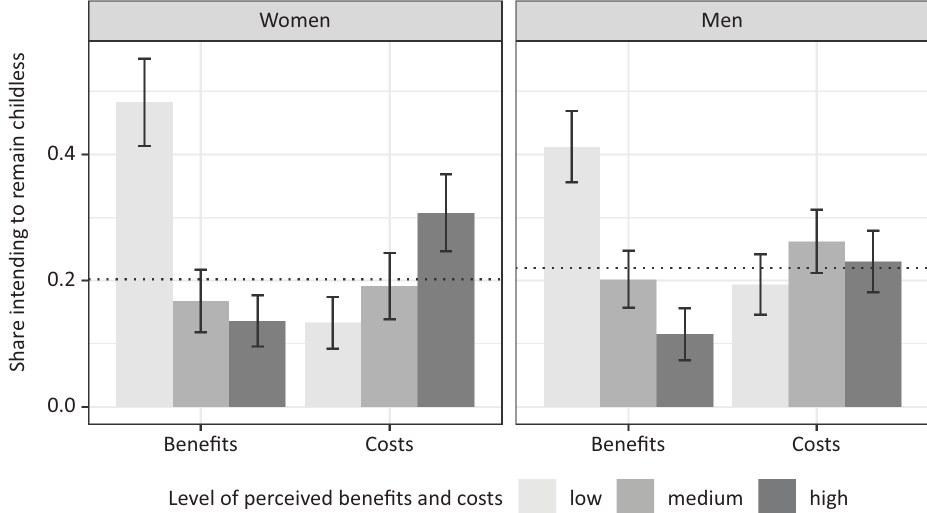
Figure 2. Respondents intending to remain childless, by perceived costs and benefits of children. Notes: Low, medium, and high values of costs and benefits denote the first, third, and fifth quantiles, i.e., the bottom 20%, those between 10% below and 10% above the median, and the top 20%; the dotted horizontal lines denote the mean share of women (left‐hand panel) and men (right‐hand panel) intending to remain childless; data weighted with post‐stratification